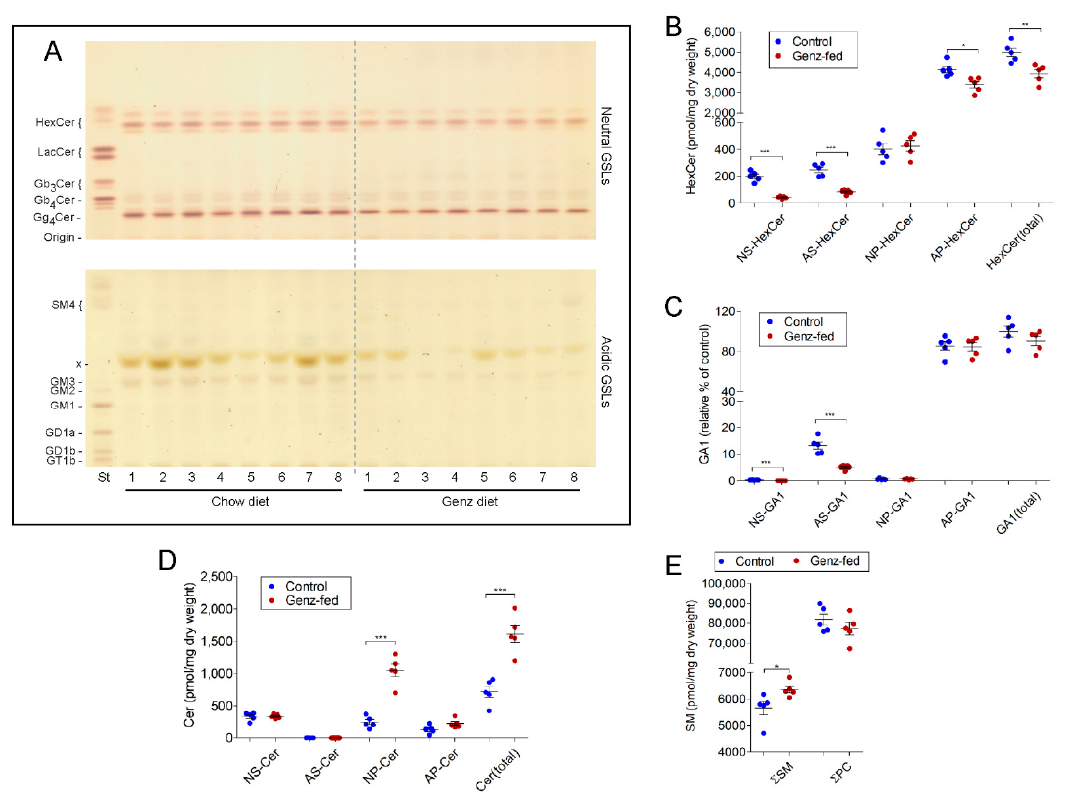
Figure 9. Genz treatment alters the sphingolipid composition in the intestine. ( A ) TLC-analysis of neutral and acidic GSLs from the intestine of Genz-treated mice. The intestine of adult mice contained predominantly the neutral GSLs HexCer and GA1. Lipids were quantified by C18-reversed phase UPLC/MS 2 in MRM mode using internal standards for each lipid class except for GA1, which was normalized to internal HexCer standards. Sphingolipids containing either non-hydroxy fatty acids (N) or alpha-hydroxy fatty acids ( A ) in combination with (C18)-sphingosine (S) or with (C18)-phytosphingosine (P) were recorded; Cer: ceramide, HexCer, hexosylceramide, GA1: asialo-ganglioside 1 or gangliotetraosylceramide (Gg 4 Cer, see Figure 1A), and SM: sphingomyelin. ( B , C ) MS 2 -analysis of HexCer ( B ) and GA1 ( C ). AS- as well as NS-species markedly decreased in the intestine of Genz-treated mice. AP-GSLs were less effectively downregulated. Genz-application did not lead to a reduction of NP-GSLs; for designation of ceramide anchors, see abbreviations. ( D ) NP-Cers increased in intestines of Genz-treated mice as compared to chow-fed controls. ( E ) The SM content was markedly elevated and PC remained essentially unaltered upon Genz treatment; significances are *, p ≤ 0.05; **, p < 0.01; ***, p < 0.001.